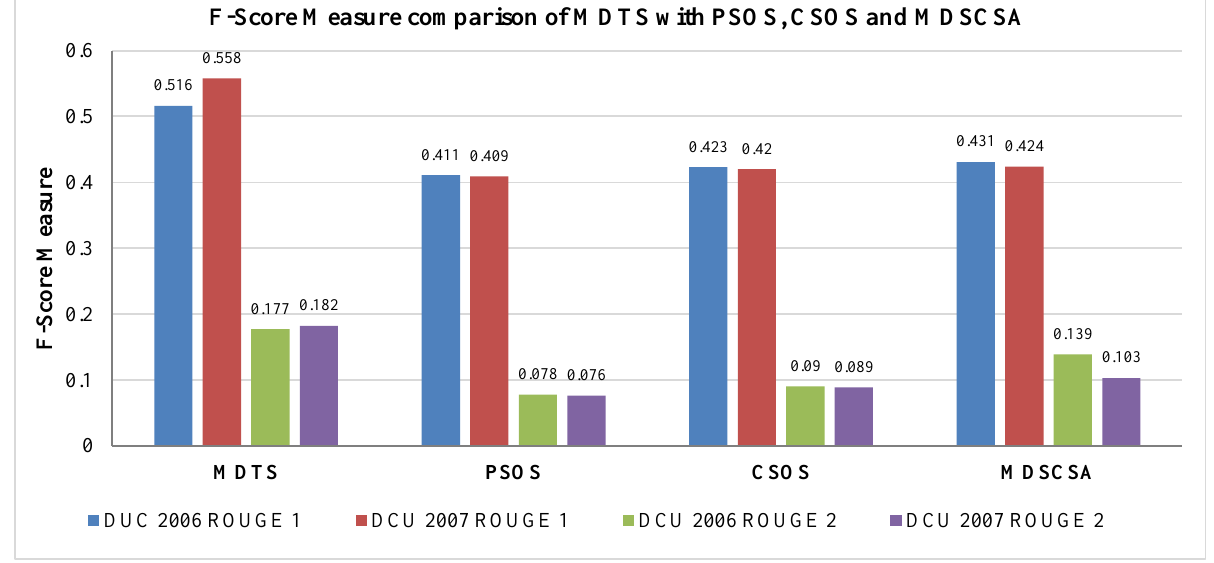
Figure 4. Comparison of F Score measure of MDTS with PSOS, CSOS and MDSCSA for DUC 2006, DUC 2007